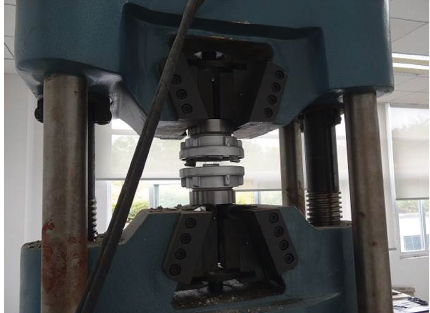
Figure 35: Experimental result